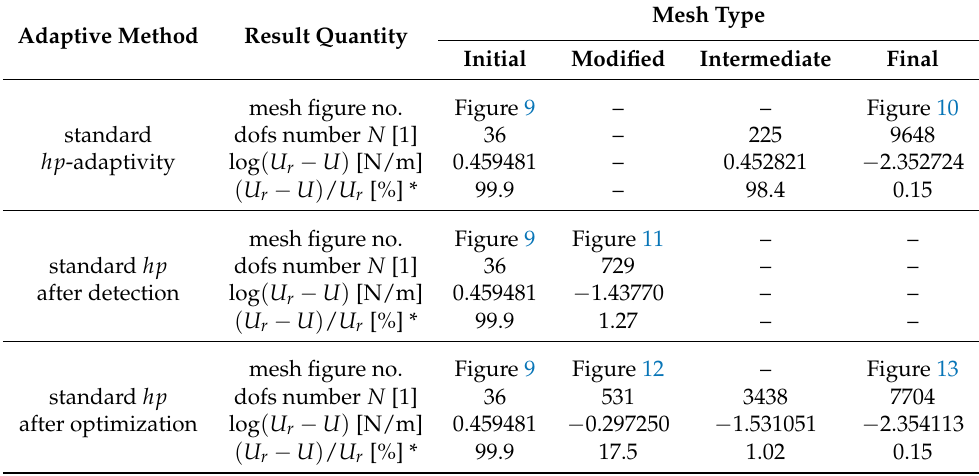
Table 1. Result summary—a quarter of the bending-dominated